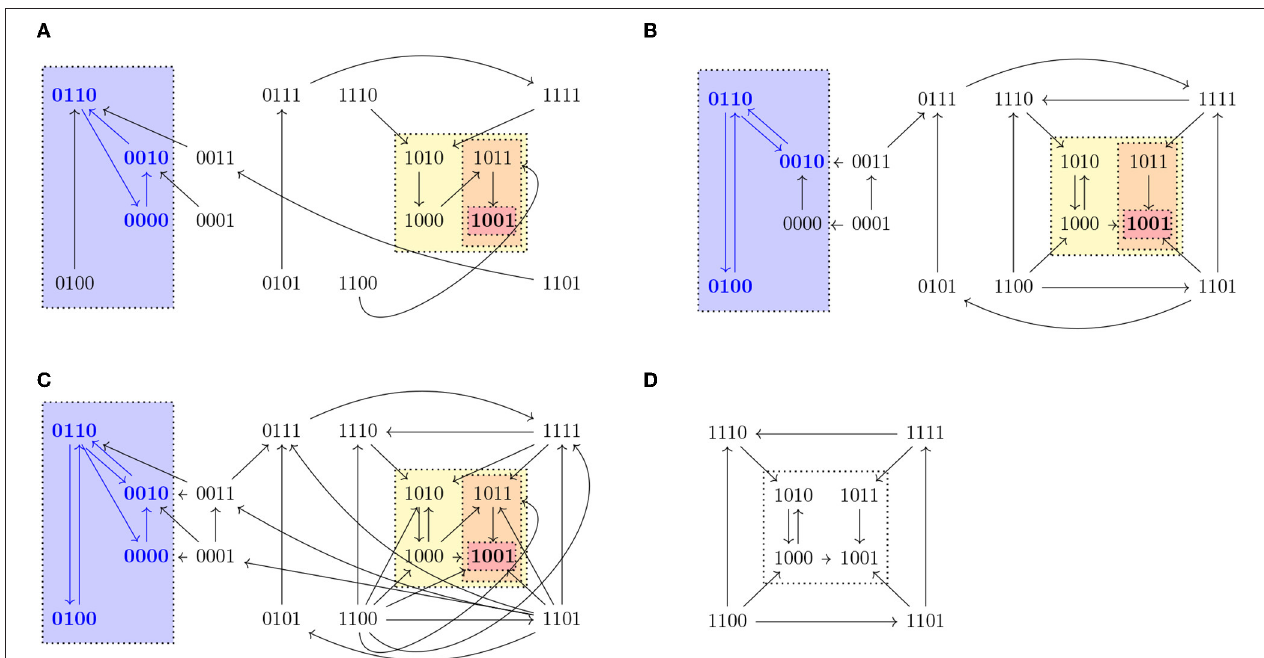
FIGURE 1 | State transition graphs of the Boolean function f = ( x 1 ¯ x 2 ∨ x 1 x 3 ∨ x 1 ¯ x 4 ∨ x 2 x 3 x 4 , ¯ x 1 ¯ x 2 x 3 ∨ ¯ x 1 x 2 ¯ x 3 ∨ ¯ x 1 x 3 x 4 , x 1 x 2 ∨ ¯ x 1 ¯ x 2 ∨ ¯ x 1 x 2 ¯ x 3 ∨ ¯ x 1 x 2 x 4 ∨ ¯ x 2 ¯ x 3 ¯ x 4 , ¯